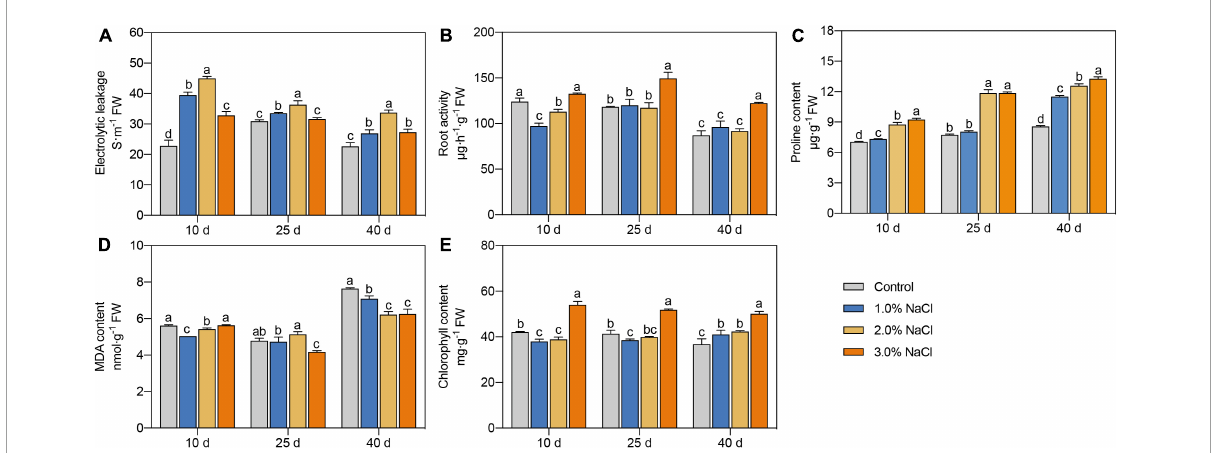
FIGURE1 Effects of different concentrations of NaCl on electrolyte leakage (A) , root activity (B) , proline content (C) , MDA content (D) , and chlorophyll content (E) of S. caseolaris seedlings. Values are means ± SD ( n = 3). Values with a different letter within a sampling date are significantly different ( P < 0.05).